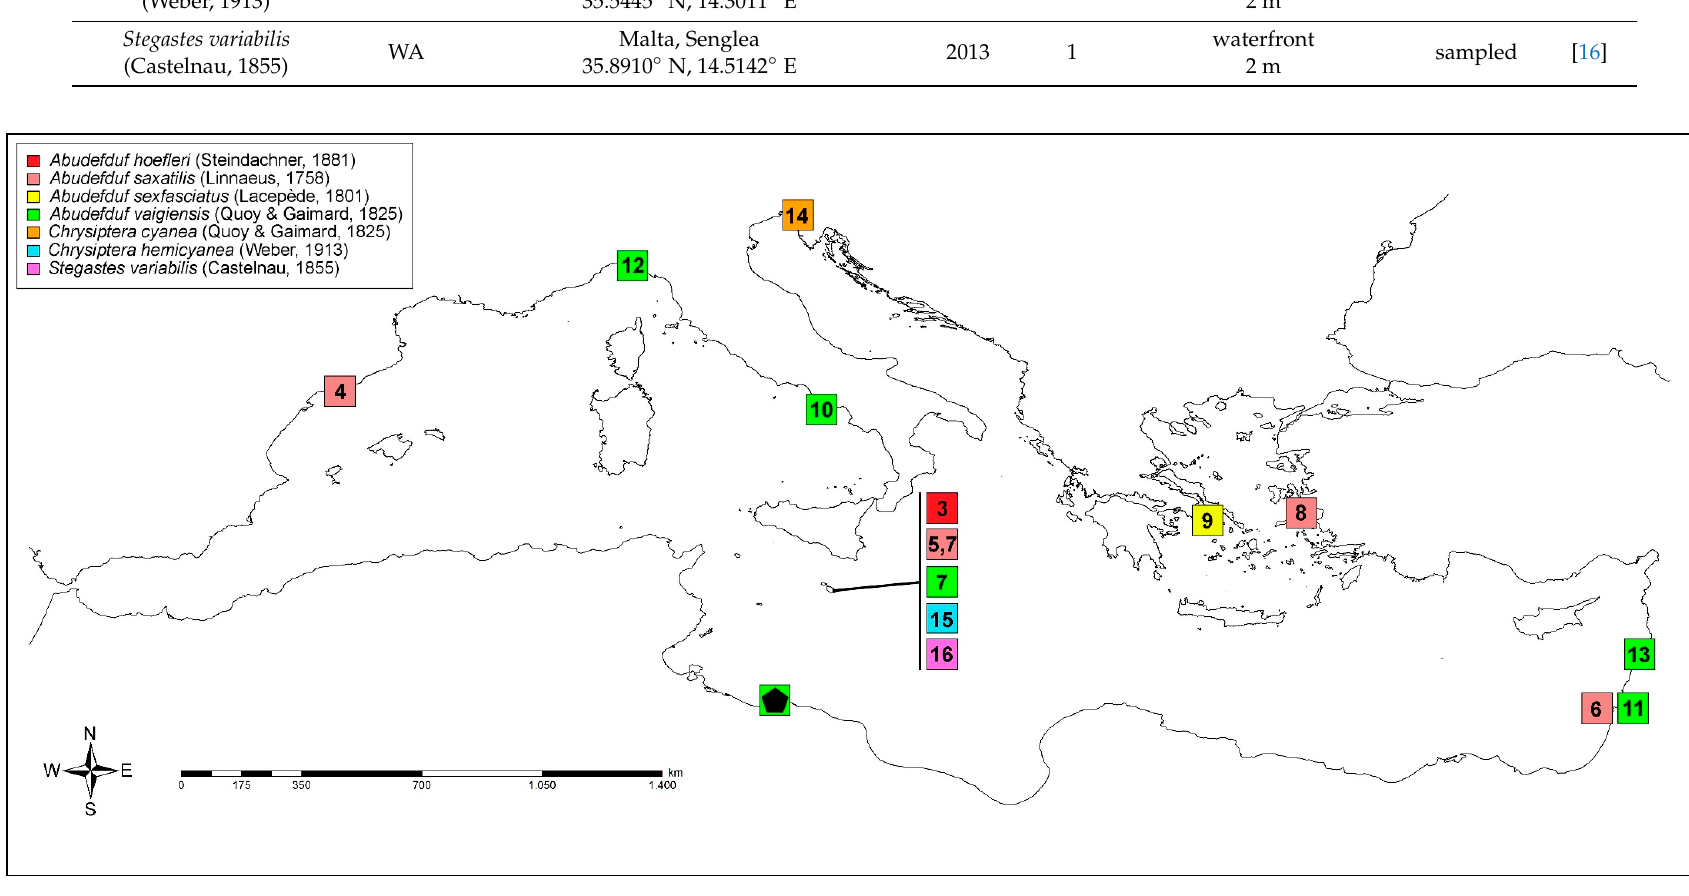
Figure 1. Sightings of alien and cryptogenic taxa belonging to the family Pomacentridae Bonaparte, 1831 from the Mediterranean Sea. Numbers refer to literature records (see also Table 1). Black pentagon refers to present record.